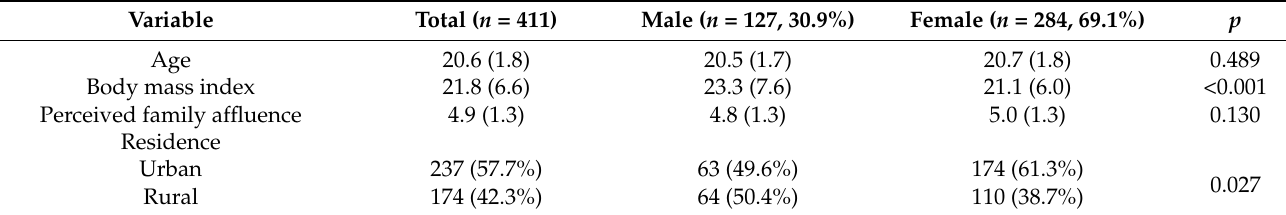
Table 1. Sociodemographic characteristics at baseline of the study